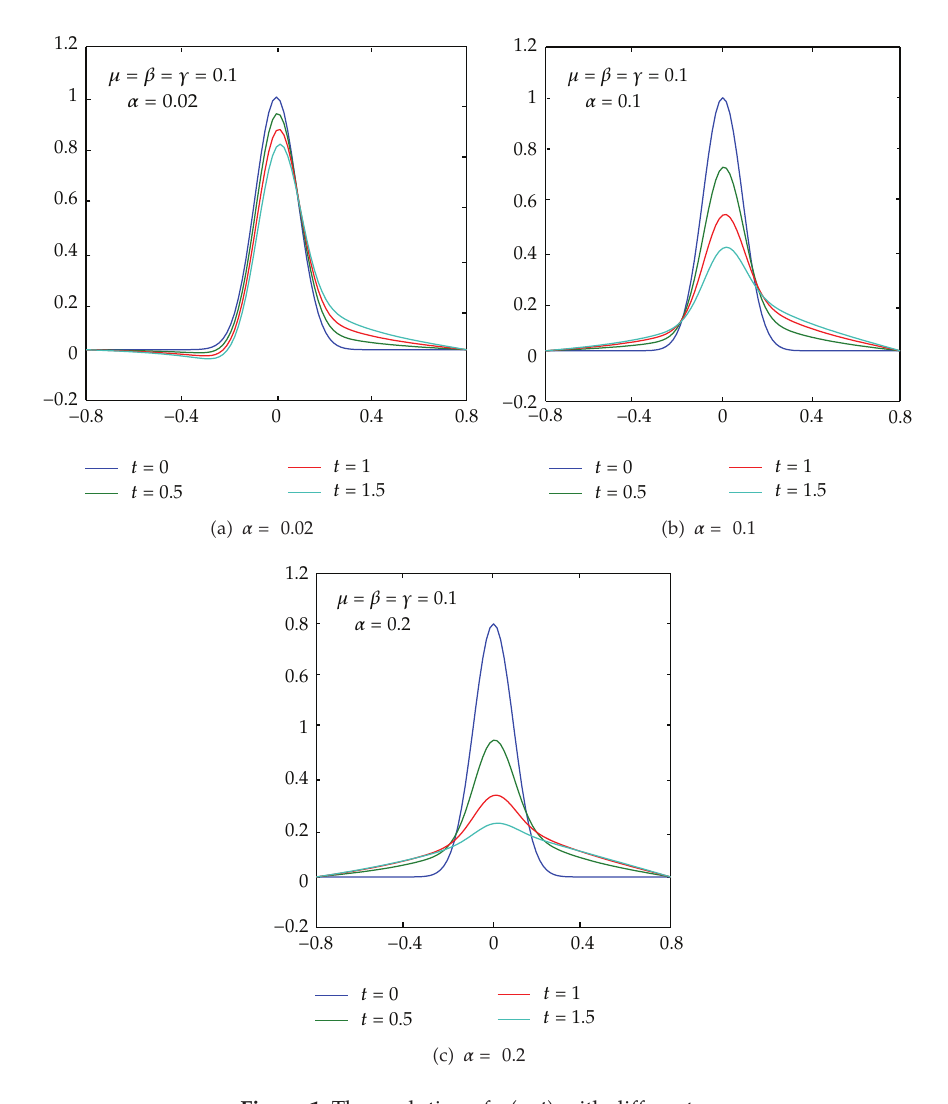
Figure 1: The evolution of u (cid:2) x,t (cid:3) with di ff erent α